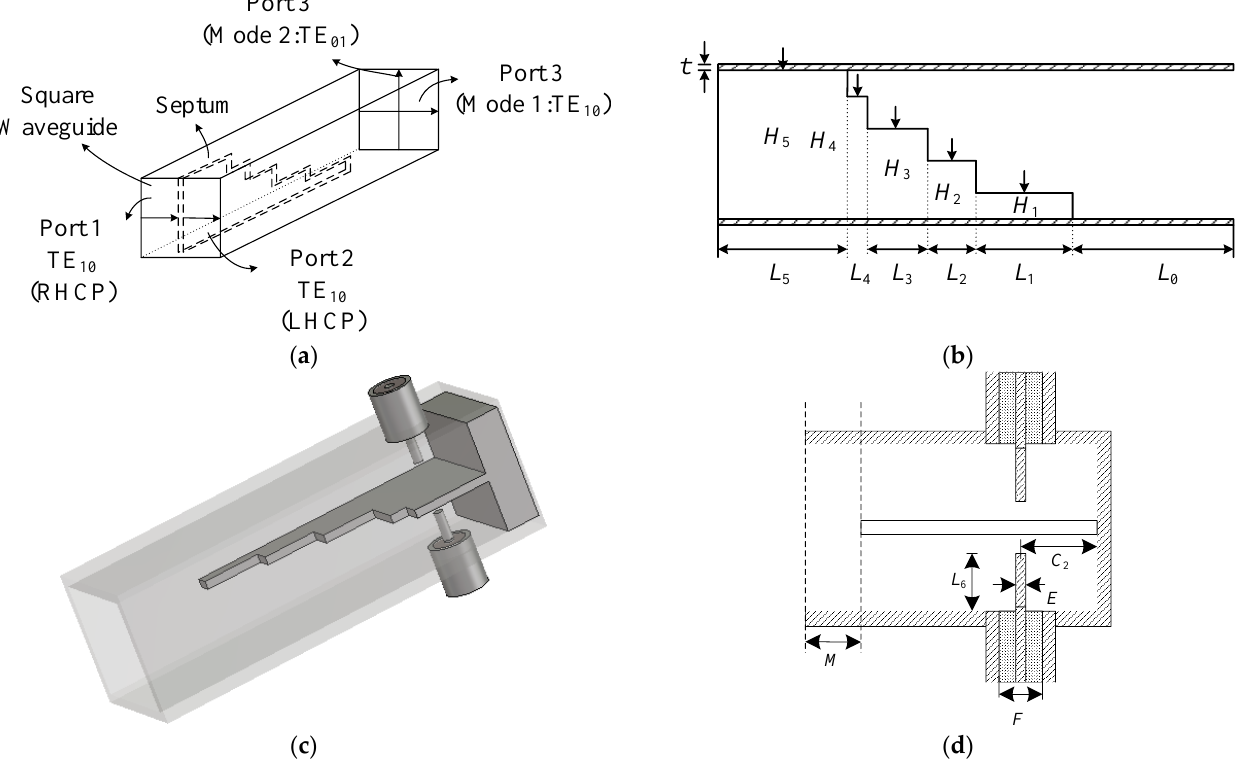
Figure 2. ( a ) Septum polarizer with waveguide modes. ( b ) Dimensional parameters. ( c ) Coaxial probe excitation. ( d ) Dimensions of the coaxial probe.